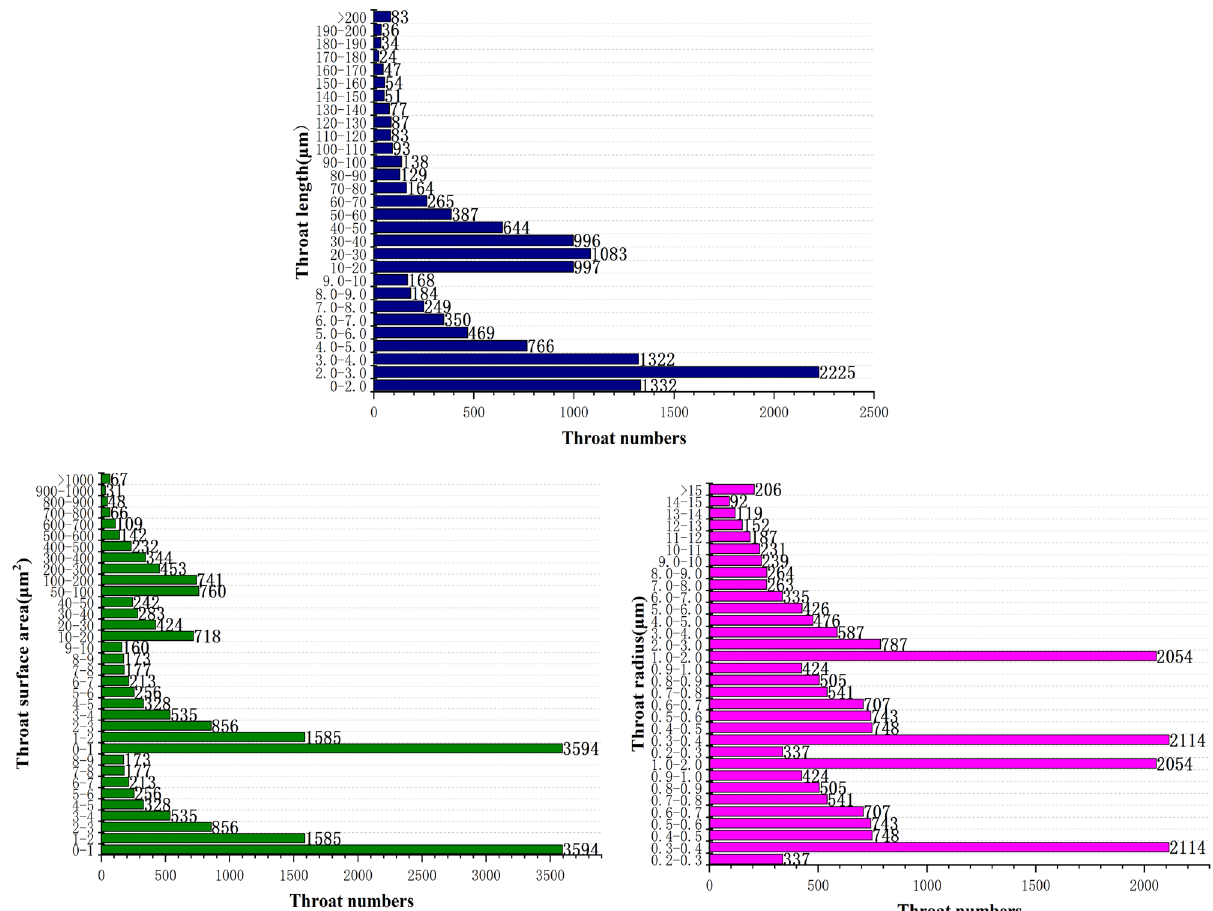
Figure 26. Statistics of throat quantitative parameters of nylon-uncured rubber